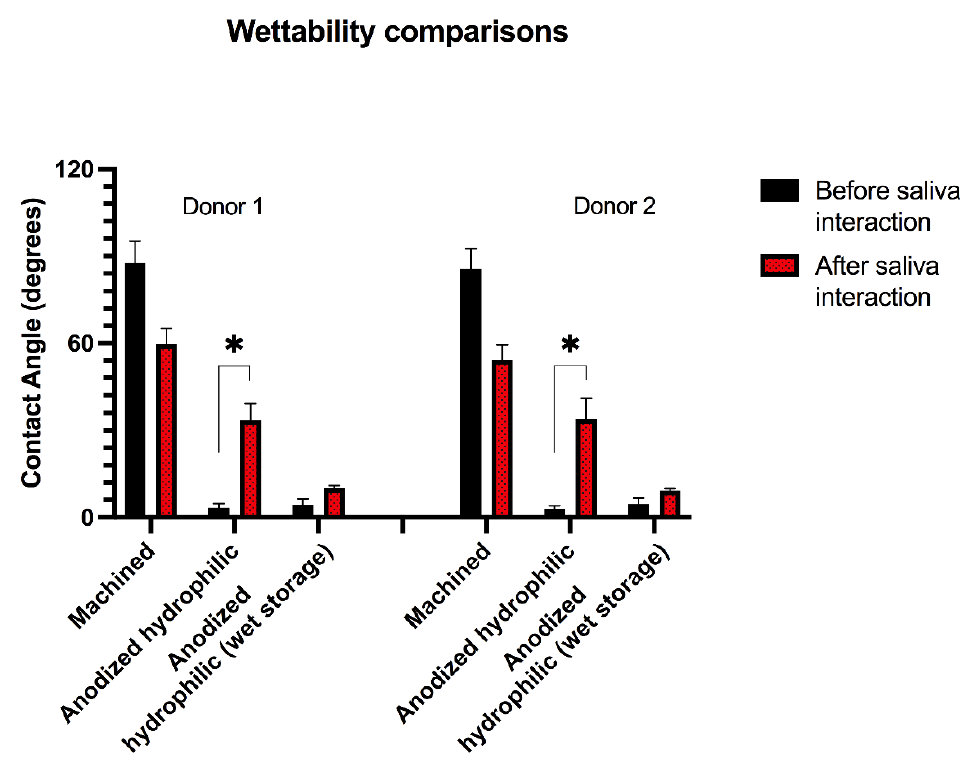
Figure 4. Wettability analysis before and after saliva interaction of two saliva donors. * Asterisks indicate statistical significance ( p < 0.05) after saliva interaction for 10 min among the tested surface groups.